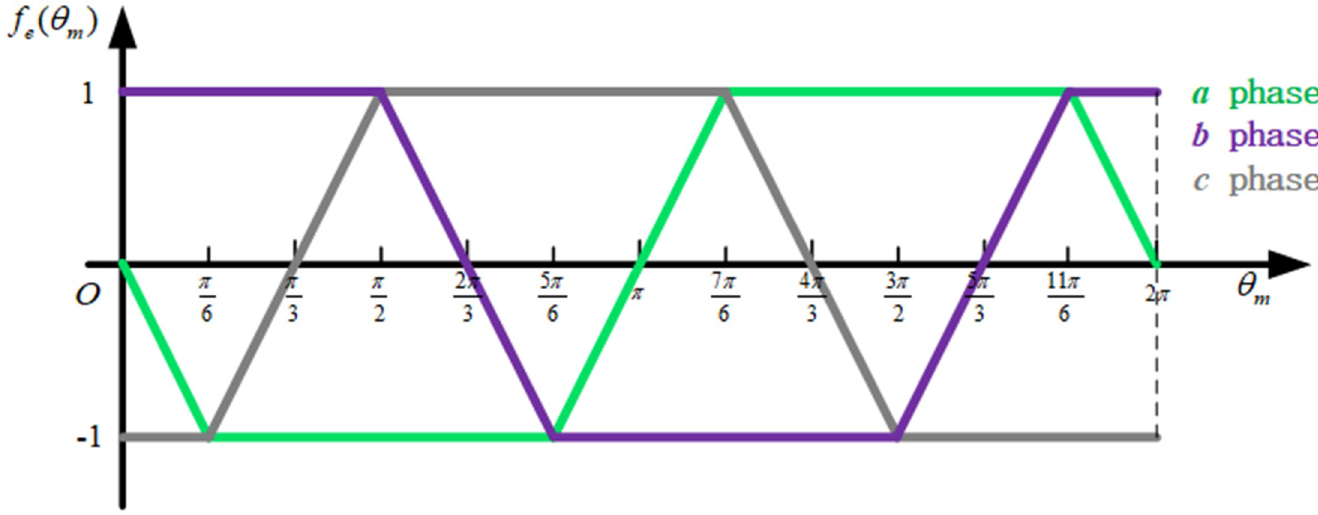
Fig 7. Back EMF waveform of